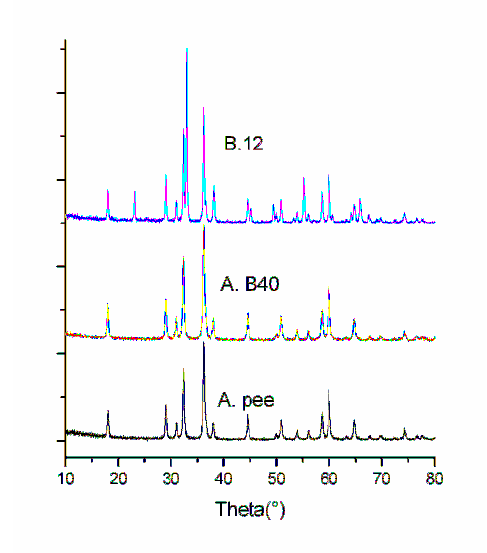
Figure 1. The XRD patterns of samples A.pee, A.B40, B.12